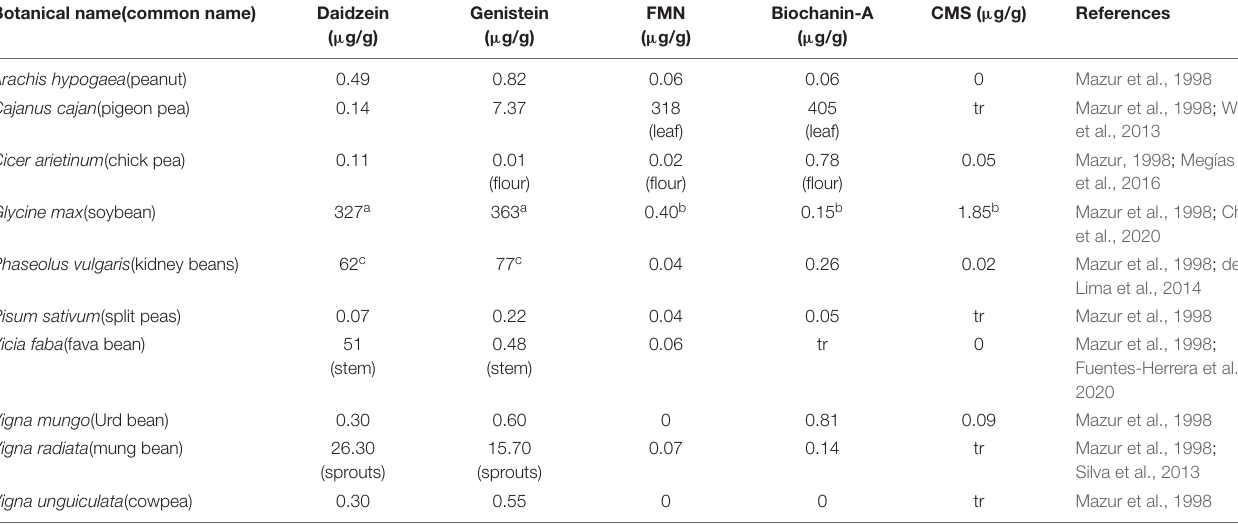
TABLE 1 | Concentration of key isoflavonoids in common food and forage